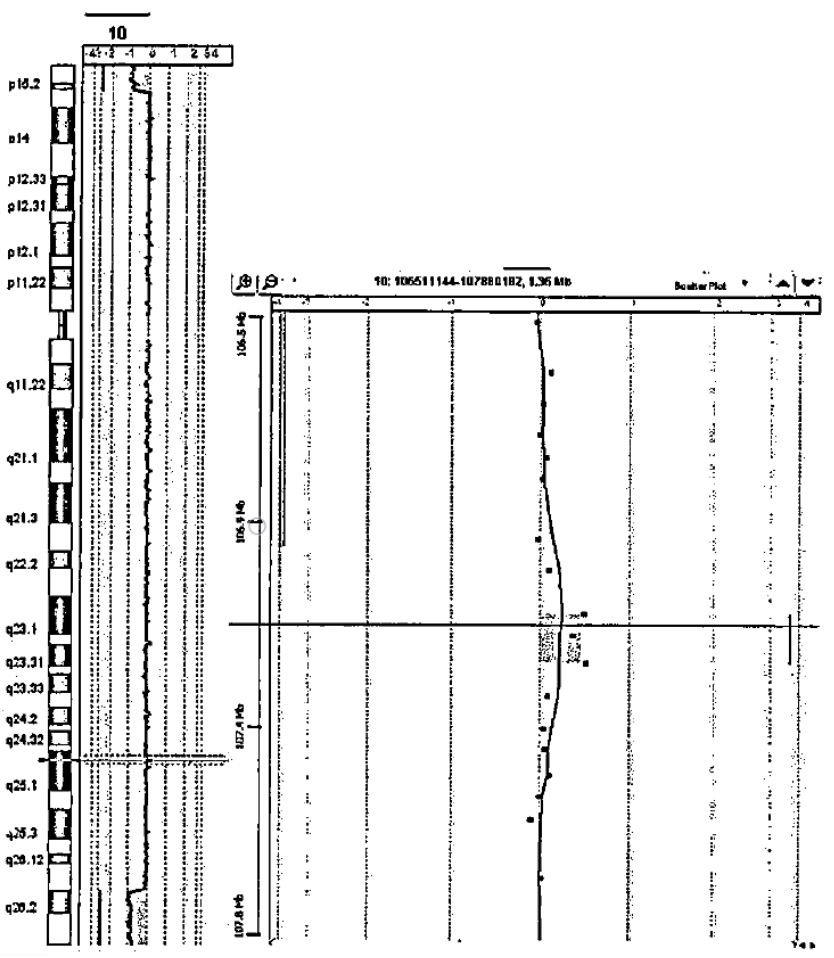
Figure 1. Microarray profile of the present case.